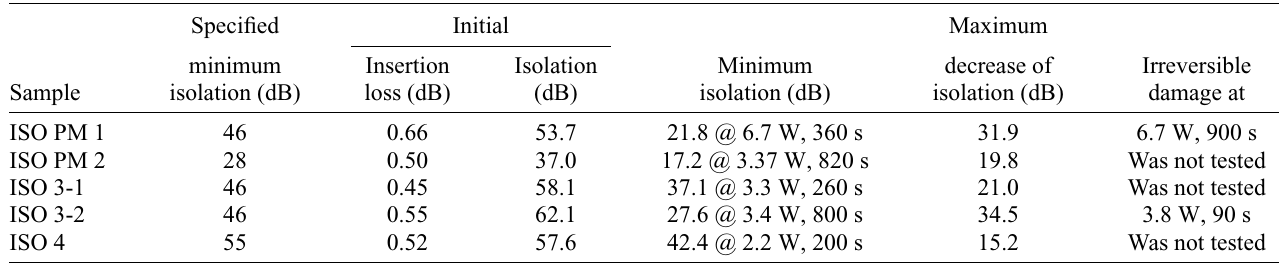
TABLE I. Testing results of isolators. All measurements are at 1550